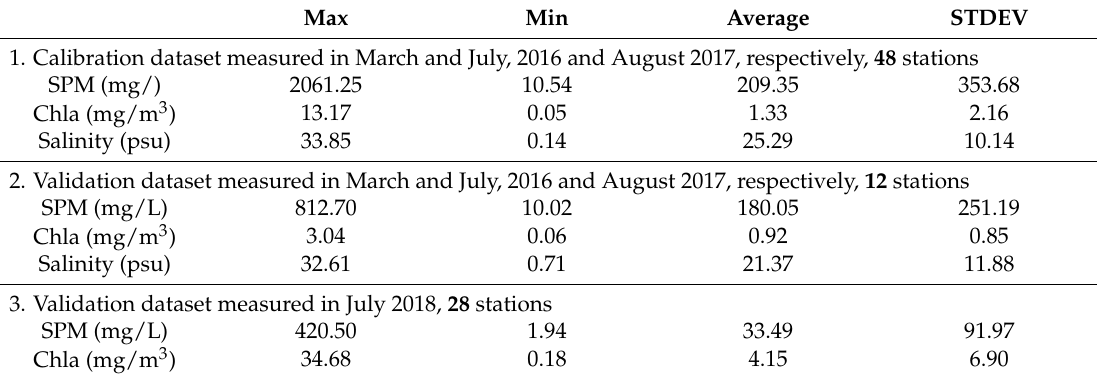
Table 2. Dates and sample numbers for the four conducted cruises and the statistics characteristics of the SPM concentration collected in the Changjiang Estuary and adjacent areas (STDEV, standard